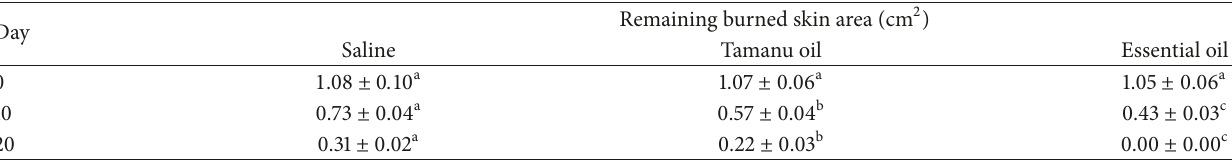
Figure 4: Evaluation of the healing rate of burn wound in experimental mice . At the beginning of experiment, all burn wounds were of similar sizes in three groups (a, b, c). In day 10, burn wound areas of tamanu oil (e) and essential oil treated mice (f) were smaller than saline treated group (d), and the significant difference of wound contraction between tamanu oil and essential oil treated mice was observed ( 𝑝 < 0.05 ). Furthermore, we found that burn wounds of essential oil treated mice were fully recovered (i). Burn wound contraction rate of tamanu oil treated mice (h) was significantly higher than that of saline treated groups (g) after 20 days. These results implied that C. operculatus essential oil has supportive effect on wound healing process and its efficiency was higher than the commercial tamanu oil. Table 2: Burn wound areas of experimental mice after 10 days and 20